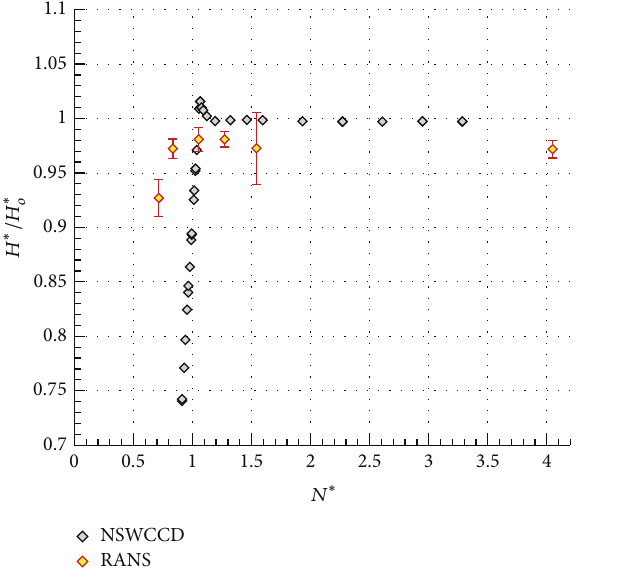
Figure 3: Cavitating RANS predictions ( 𝐻 ∗ ) compared to experi- mental measurements at NSWCCD. Note: error bar +/− represents standard deviation ( 𝜎 ) of the 𝐻 ∗ time series.